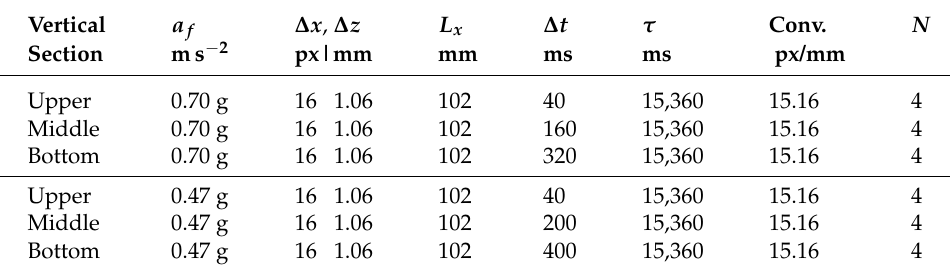
Table A2. PIV discretization parameters—vertical